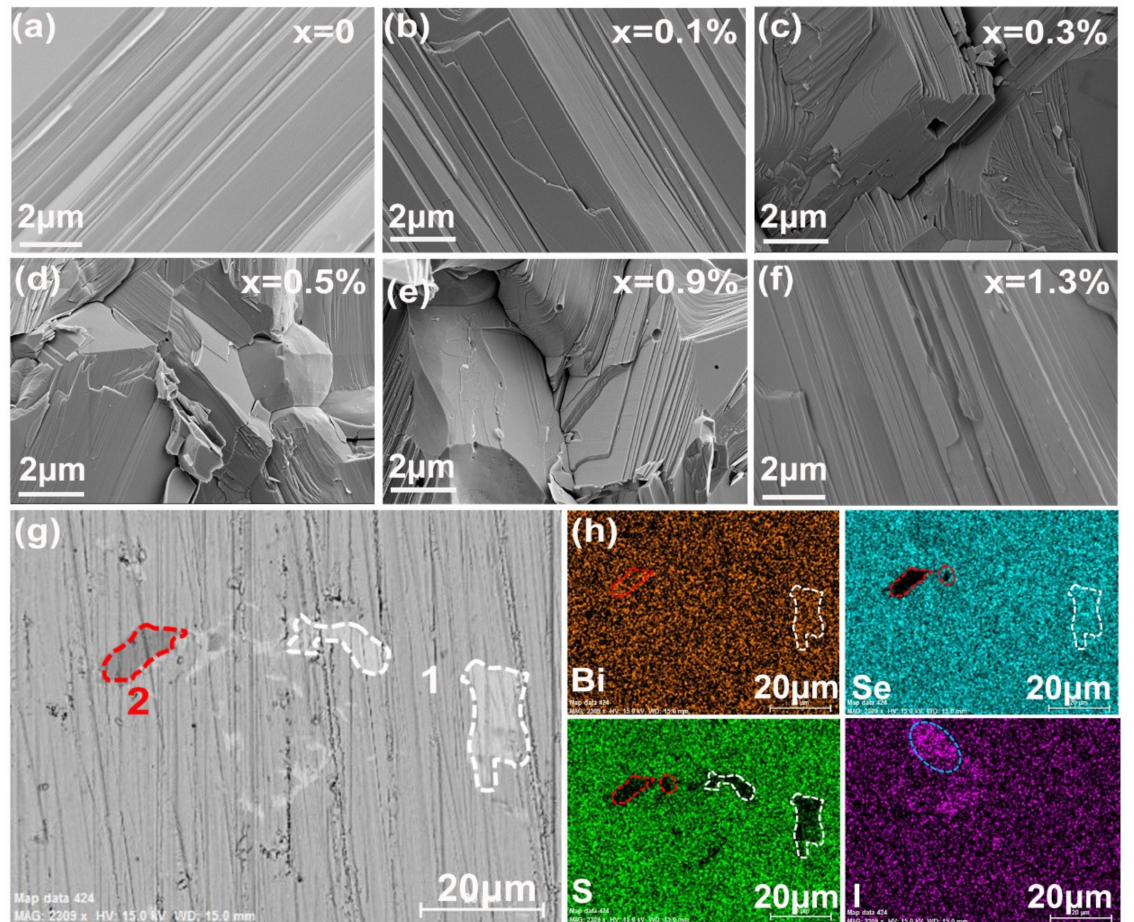
Figure 2. ( a – f ) SEM pictures of fresh fracture surfaces for Bi 2 Se 1 − x I x S 2 with x = 0, 0.1%, 0.3%, 0.5%, 0.9%, and 1.3%; ( g ) BES image for Bi 2 Se 1 − x I x S 2 (x = 1.3%). The lighter contrast areas are indicated as 1, while the deep contrast areas are indicated as 2; ( h ) Distribution of the corresponding elements Bi, Se, S and I on the sample surface in ( g